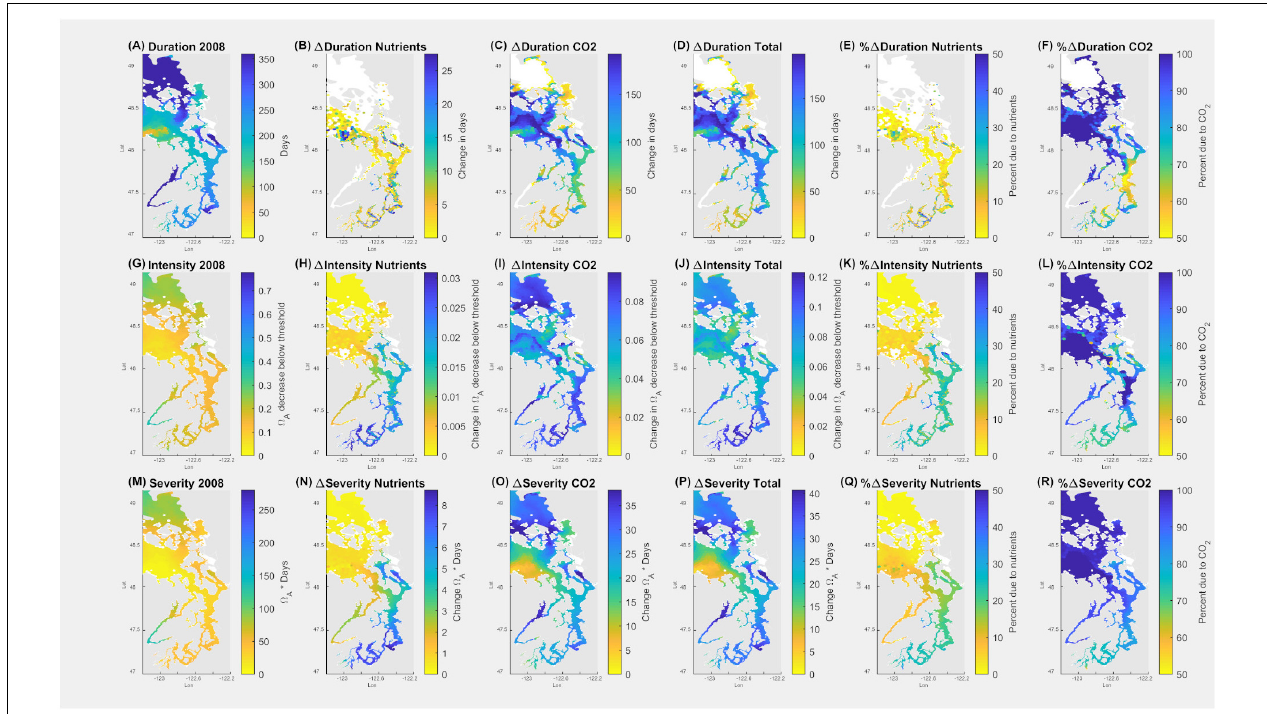
FIGURE 8 | Application of pteropod threshold for survival in the upper 100 m (14 days at (cid:127) ar = 0.95) over the annual scale in the Salish Sea. Model outputs demonstrate current duration, intensity, and severity of the conditions (A,G,M) . The second column indicates all the changes due to nutrients (B,H,N) ; the third column depicts the changes due to atmospheric CO 2 (C,I,O) , the fourth column (D,J,P) shows total changes due to both nutrients and atmospheric CO 2 . The fifth column (E,K,Q) depicts % changes in (cid:127) ar due to nutrients, and the sixth column (F,L,R) is % change in (cid:127) ar due to atmospheric CO 2 . Values of zero are masked in white.